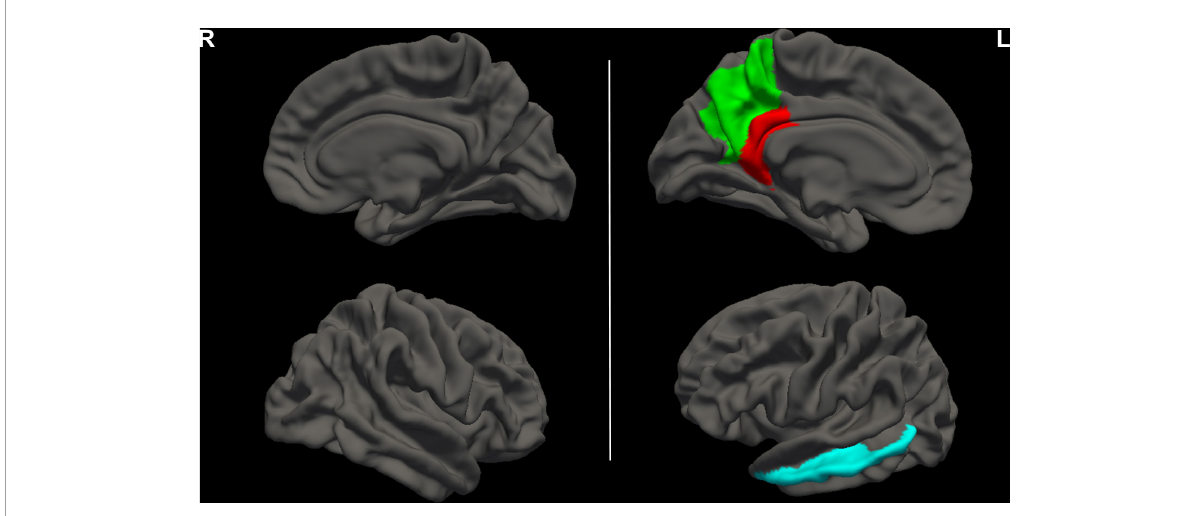
FIGURE2 Brain regions with decreased CC values in patients with ESKD compared to HCs. These results were corrected for multiple comparisons (FDR-corrected p < 0.05). The green area represented the left precuneus. The blue area represented the left middle temporal cortex. The red area represented the left isthmus cingulate cortex. R, right; L, left; CC, cortical complexity; ESKD, end-stage kidney disease; HCs, healthy controls; FDR, false discovery rate.